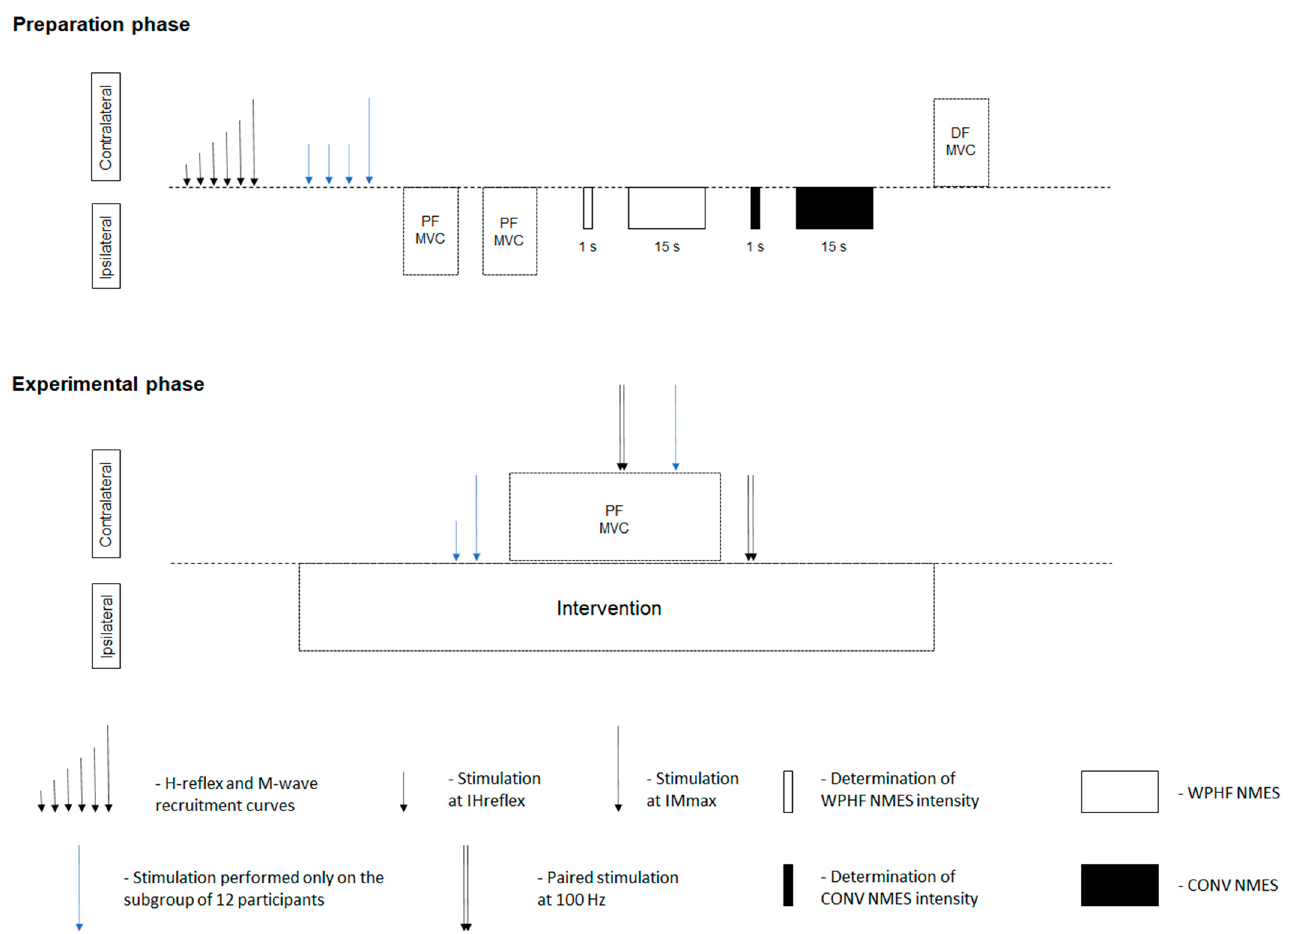
Figure 1. Schematic diagram of the experimental design. IHreflex = stimulation intensity used to elicit a maximal H-reflex. IMmax = 120% of stimulation intensity used to elicit a maximal M-wave. PF MVC = plantar flexor maximal voluntary contraction. Stimulation intensity of wide-pulse, high- frequency neuromuscular electrical stimulation (WPHF NMES, stimulation frequency: 100 Hz, pulse duration: 1 ms) and conventional (CONV) NMES (stimulation frequency: 30 Hz, pulse duration: 0.1 ms) was set to produce an initial force level of 10% maximal voluntary contraction torque. DF MVC = dorsiflexor maximal voluntary contraction. The 15 s intervention on the left leg was either rest (REST), a voluntary contraction at 10% MVC torque (VOL), and conventional (CONV) or wide-pulse high-frequency (WPHF) NMES. The PF MVC during the intervention phase lasted for 5-s. EMG signals of the soleus muscle were recorded throughout the experiment on a subgroup of 12 participants. Blue arrows represent stimulations performed exclusively on the subgroup of 12